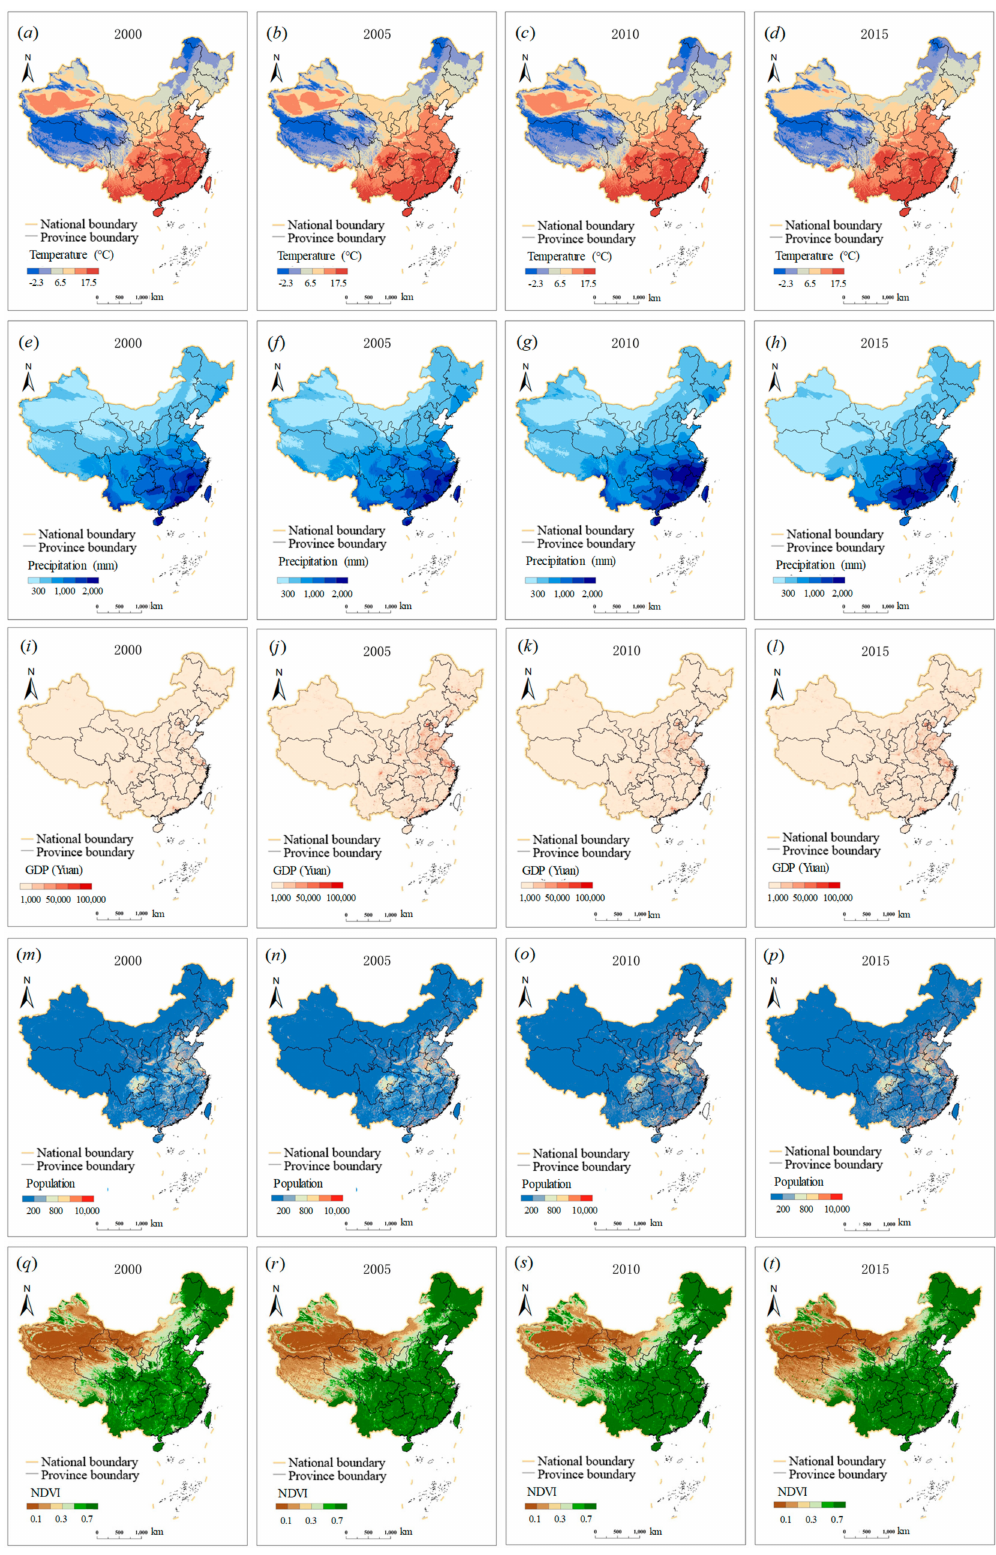
Figure 3. Spatial distribution of the potential driving factors in China from 2000 to 2015. Note: ( a – d ) temperature, ( e – h ) precipitation, ( i – l ) GDP, ( m – p ) population, and ( q – t )